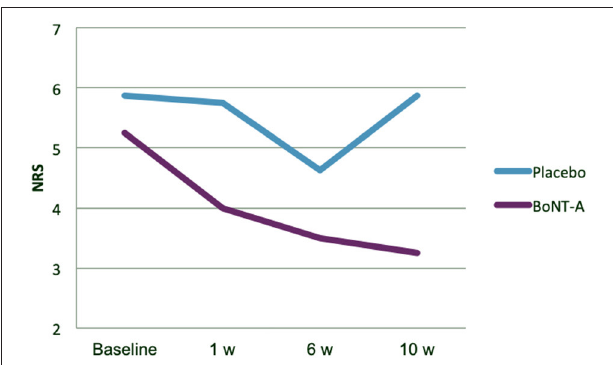
FIGURE 3 | Exploratory analysis of mean pain intensity, by treatment group. BoNT-A, botulinum toxin-A; NRS, Numerical Rating